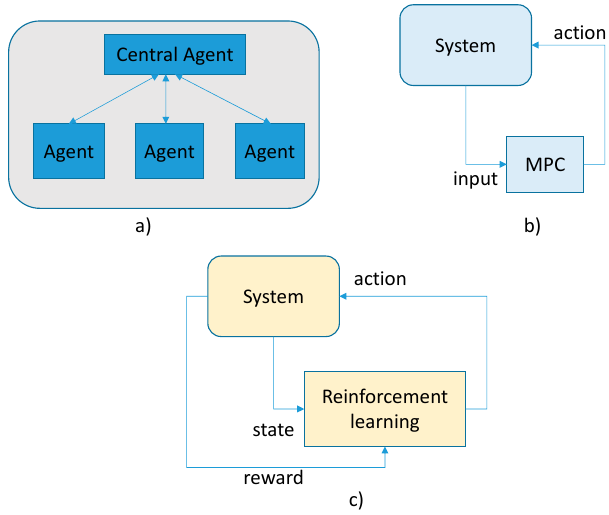
Figure 5. Optimal control methods.